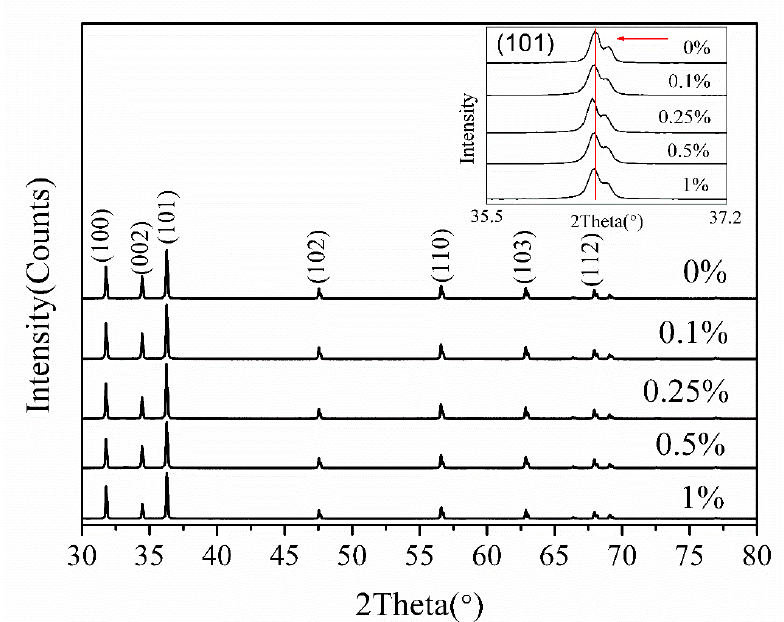
Figure 1. XRD spectra of undoped ZnO and lightly Cu-doped ZnO with concentrations of 0.1%, 0.25%, 0.5%, and 1%. The inset is the magnified patterns of (101) crystal direction.